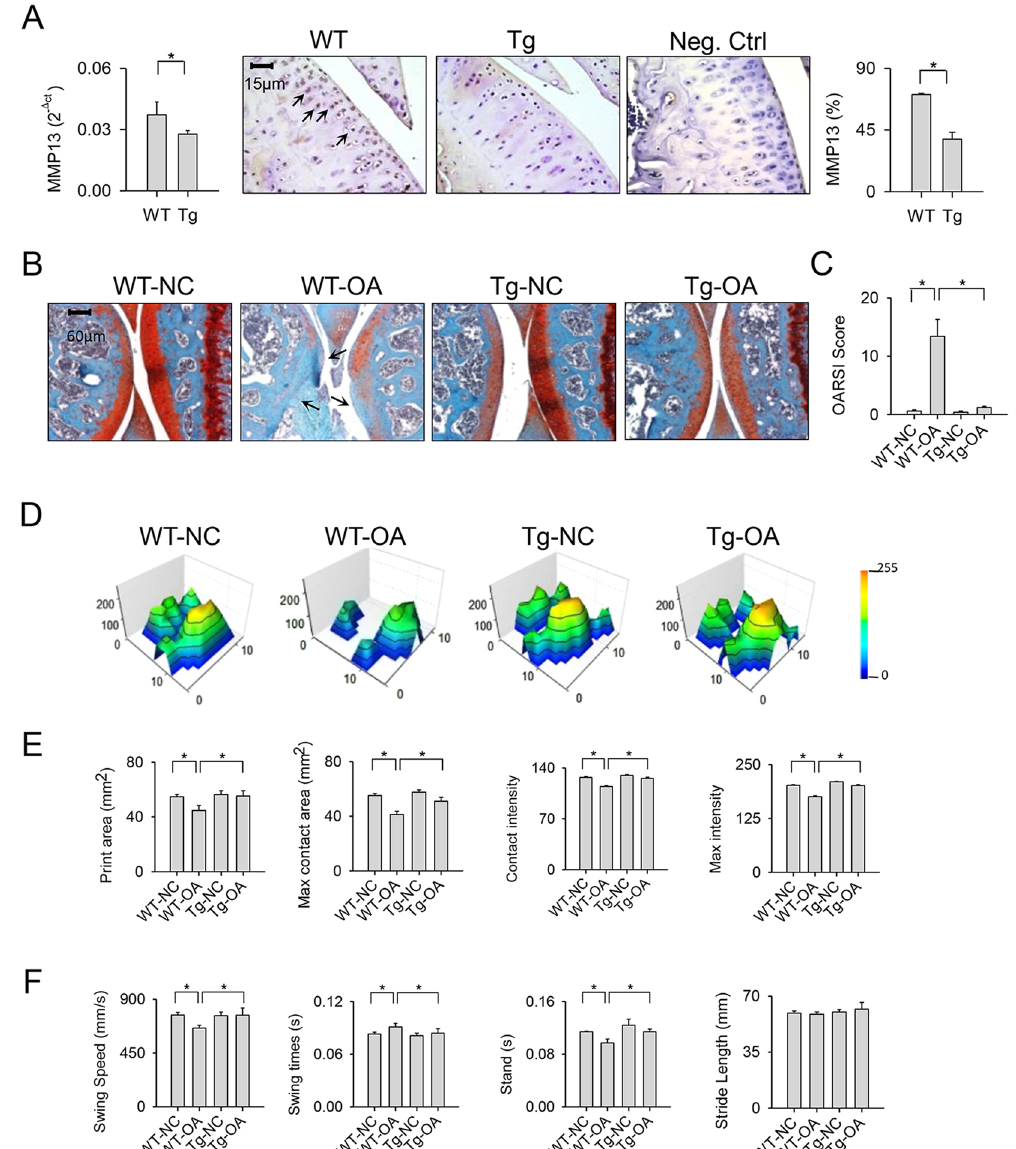
Figure 4. Cartilage morphology and gait characteristics of collagenase-affected joints in miR-29aTg mice and wild-type mice. ( A ) Articular chondrocytes in the miR-29aTg mice displayed weak MMP13 mRNA expression and immunostaining (arrows) in knee joints. ( B ) Injured knees in the miR-29aTg mice showed smooth articular cartilage morphology (arrows) and intense Safarin O staining in association with ( C ) lower OARSI scores than those of the wild-type mice. ( D ) The miR-29aTg mice showed regular footprint histograms in the collagenase-injected knees. The miR-29aTg mice exhibited minor response to the collagenase disturbance of ( E ) print area, maximum contact area, contact intensity, maximum intensity affected joints. ( F ) The collagenase disturbance of wing speed, swing time, and stand time were lessened in the miR-29aTg mice. Each bar plot stands for mean ± standard error calculated from 8 animals in each group and analyzed by a parametric analysis of variance (ANOVA) and a Bonferroni post-hoc test. Asterisks ( * ) stands for significant difference between